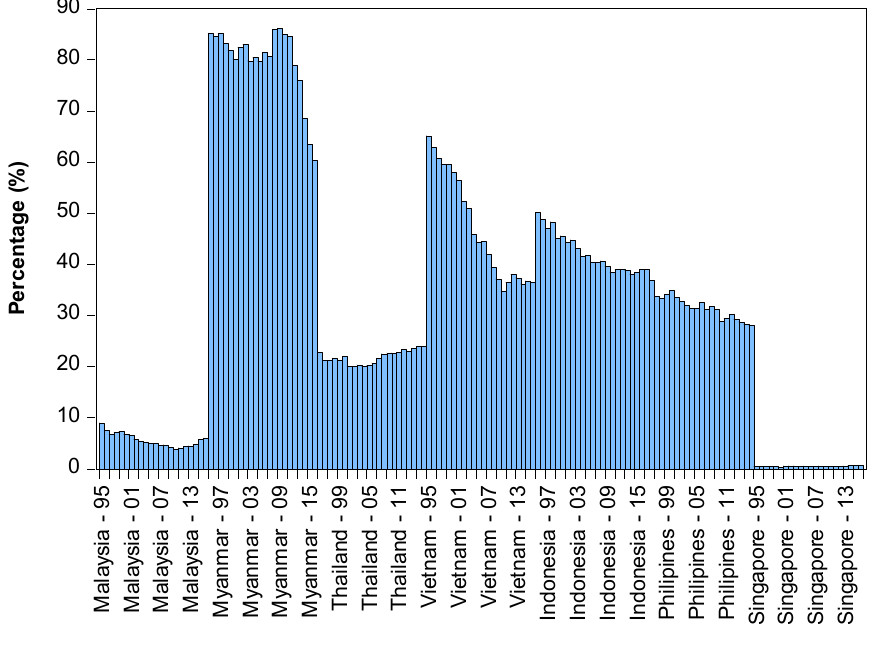
Figure 1. ( a ) Panel data plots of the CO 2 emissions per capita for Association of Southeast Asian Nations (ASEAN) countries; ( b ) Panel data plots of the real GDP (Gross Domestic Product) per capita for ASEAN countries; ( c ) Panel data plots of renewable energy production in % for ASEAN countries.